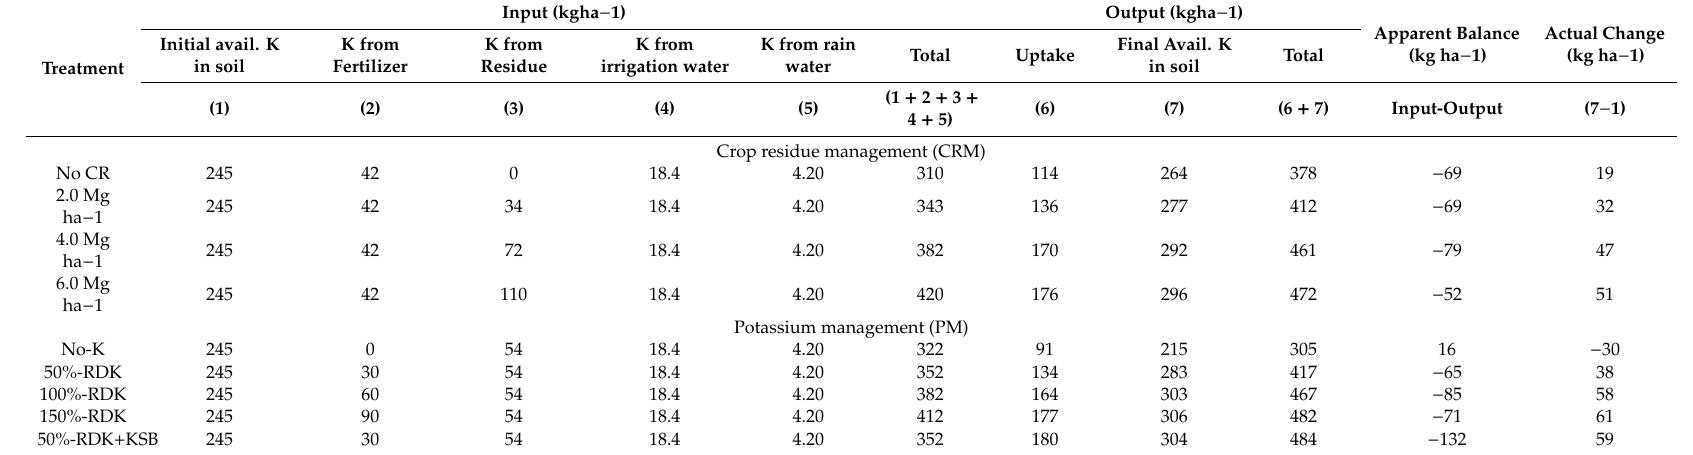
Table 7. Potassium budgeting as influenced by crop residue and potassium management in zero tillage maize–wheat system (at the end of two years crop cycle).